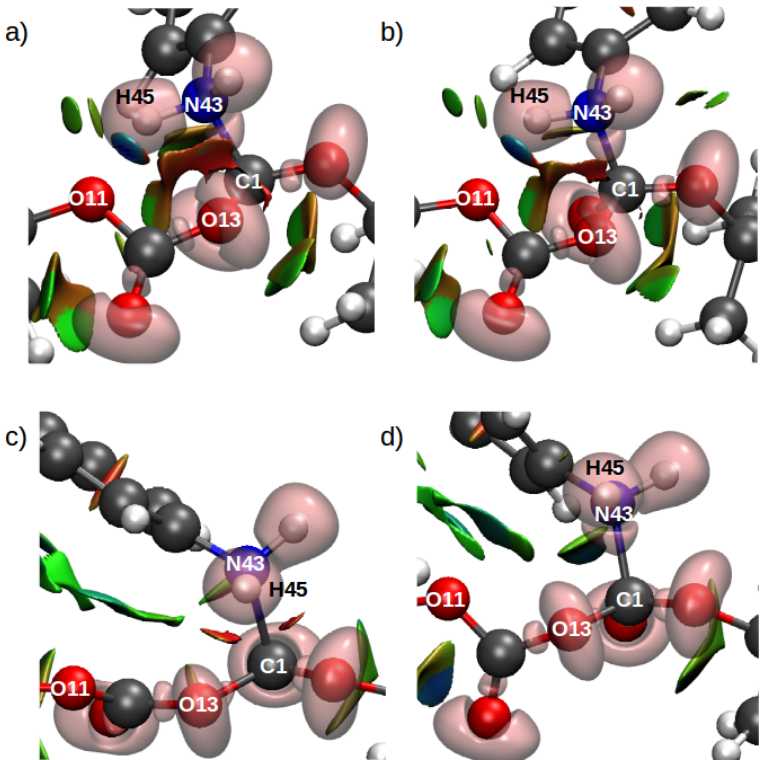
Figure 9. Combined ELF/NCI surfaces for the TS structures for the rate-limiting step in Scheme 1c. ( a ) GP, ( b ) DCM, ( c ) Configuration C1, ( d ) Configuration C2. The isovalue for ELF was 0.83, and for